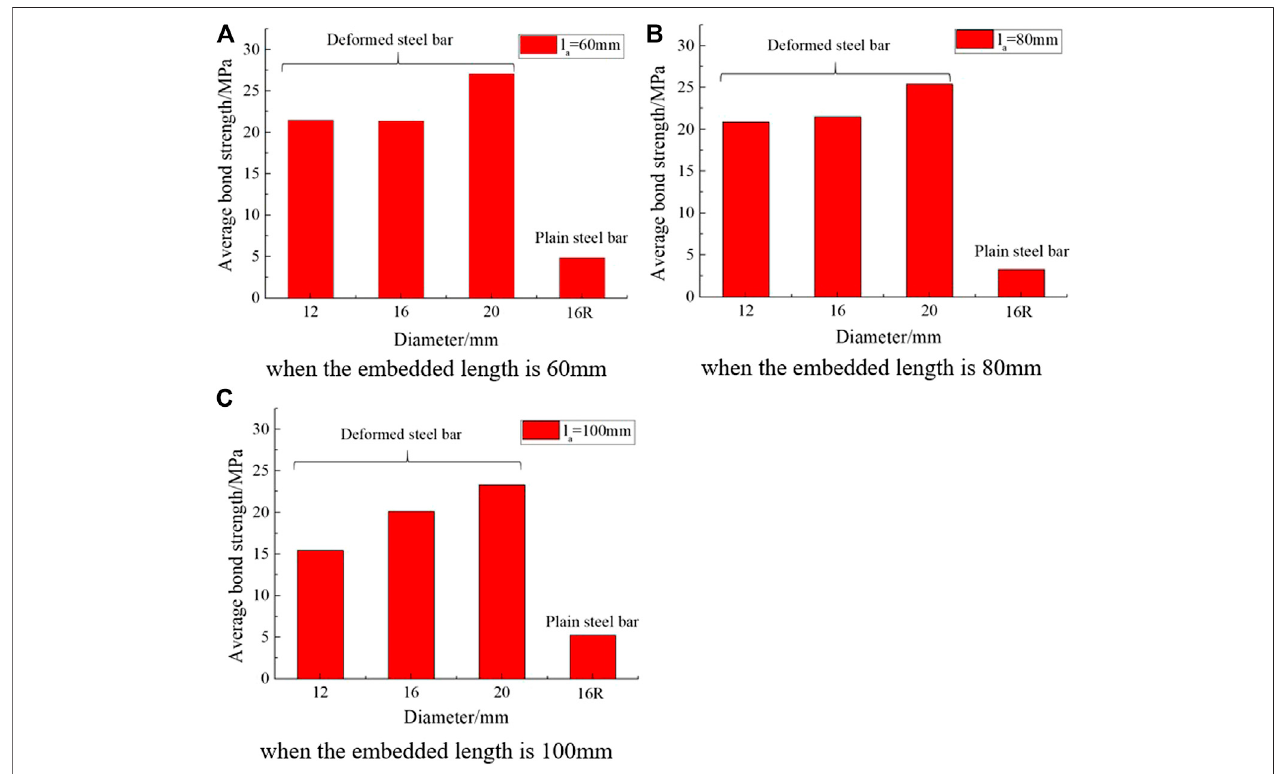
FIGURE 9 | The in fl uence of bar diameter and the shape of the bar ’ s surface on bond strength.